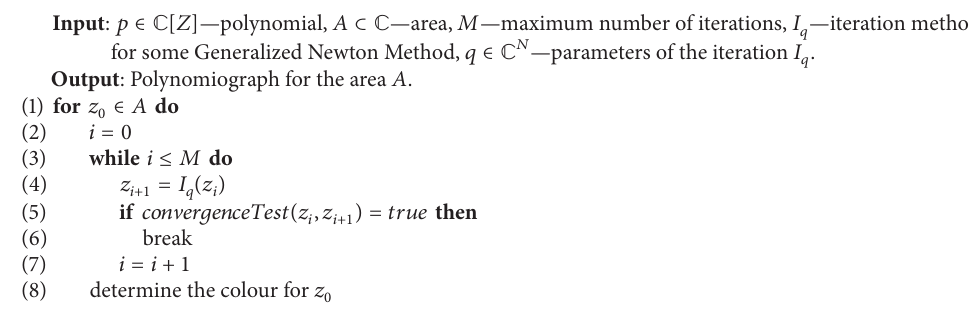
Algorithm 1: Polynomiograph